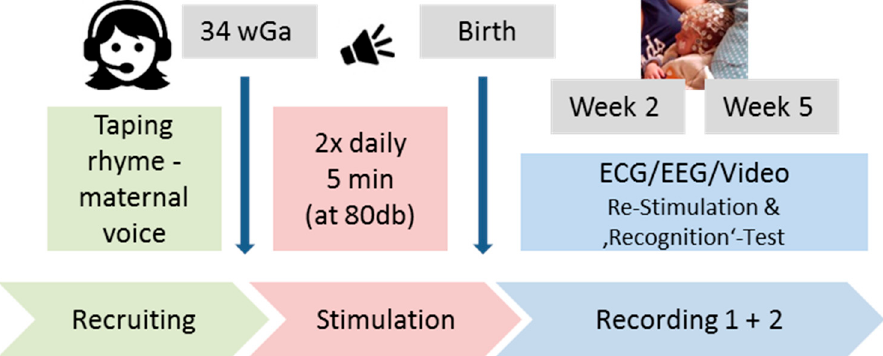
Figure 1. Experimental procedure. Pregnant women ( n = 34) were asked to tape two different nursery rhymes and were afterward randomly assigned to two groups. The experimental group (EG, n = 23) replayed one rhyme (80 dB over speakers; twice a day for five minutes) from week 34 of gestation until birth (i.e., up to ~42 days). The control group (CG, n = 11) did not replay any rhyme. Two and five weeks after birth infants’ electrocardiography (ECG) and high density electroencephalography ( hd EEG) were recorded during baseline (silence) and auditory stimulation periods with both rhymes, each presented with the maternal and an unfamiliar female voice.